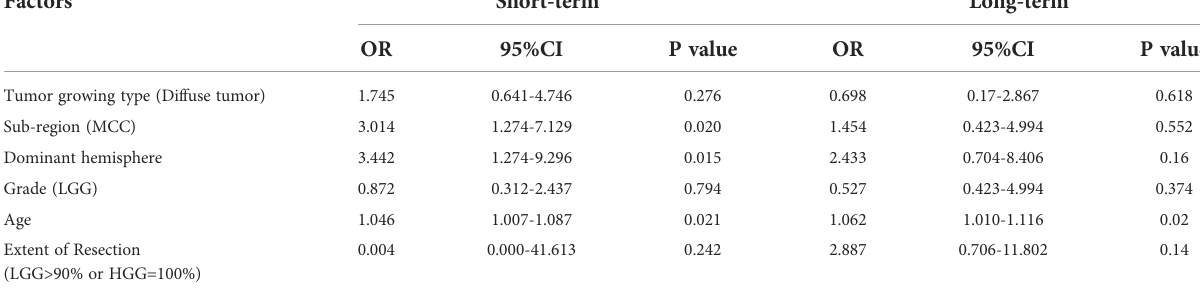
TABLE 6 Analysis of multivariate logistic regression for postsurgical de fi cit.